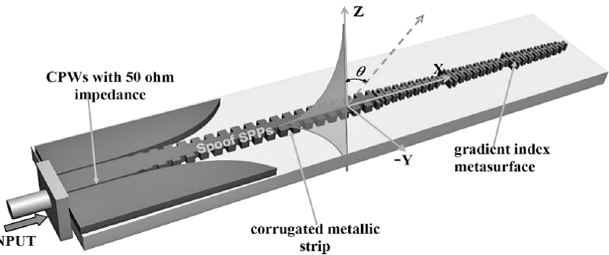
Fig. 1. An emitter proposed in [14] to convert SPP modes to radiated modes.